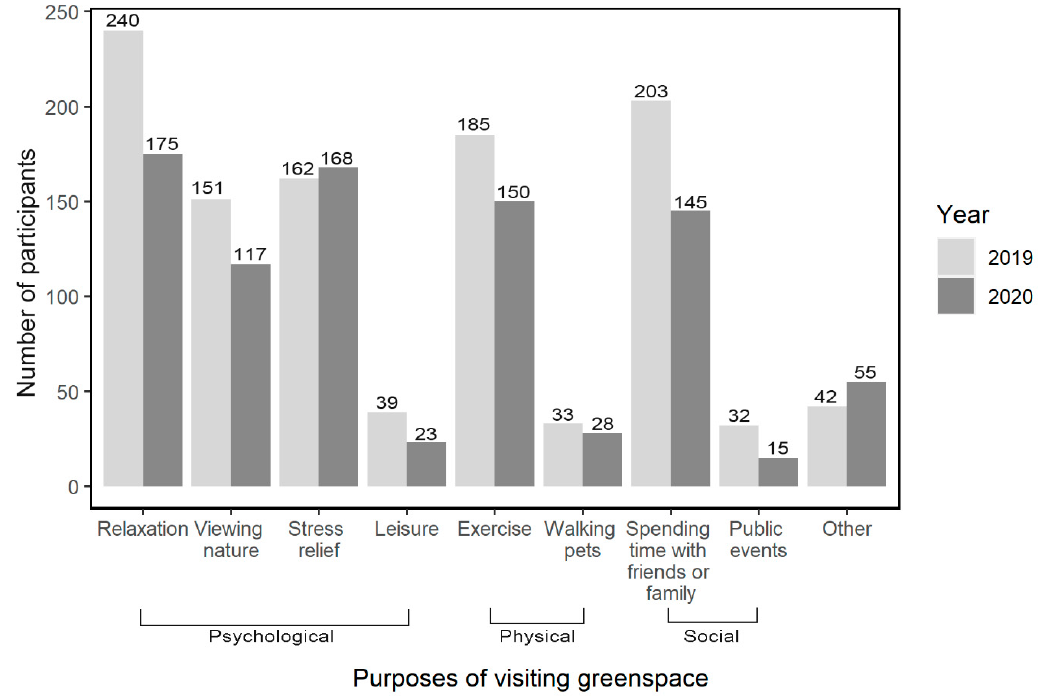
Figure 3. Purposes for visiting greenspace in 2019 (pre-pandemic) and during the COVID-19 pandemic (2020) among the 322 survey participants. Multiple choices were allowed among the